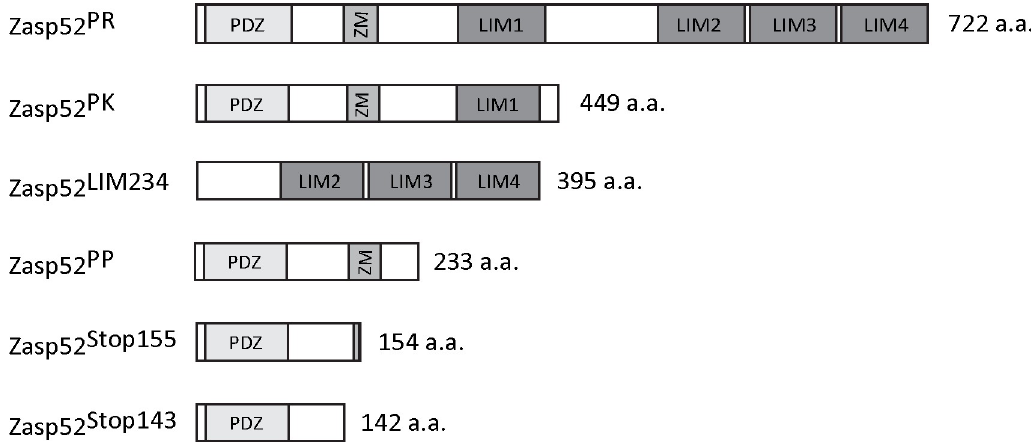
Fig 2. Schematic of different Zasp52 proteins used. Size of proteins is indicated in amino acids (a.a.). The full-length protein Zasp52-PR is shown for comparison.